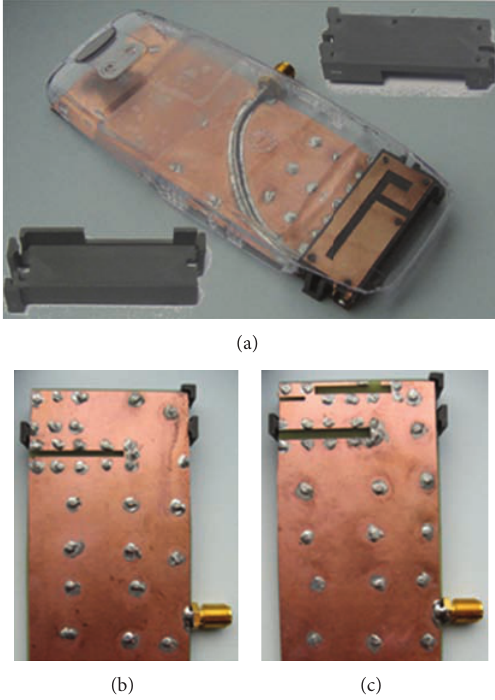
F 25: Manufactured antenna prototypes: (a) dual-band PIFA and rear view of the, (b) quad-band, PIFA, and (c) the hexaband PIFA. In (a) the carrier to attach the metal plate and the plastic cover are also